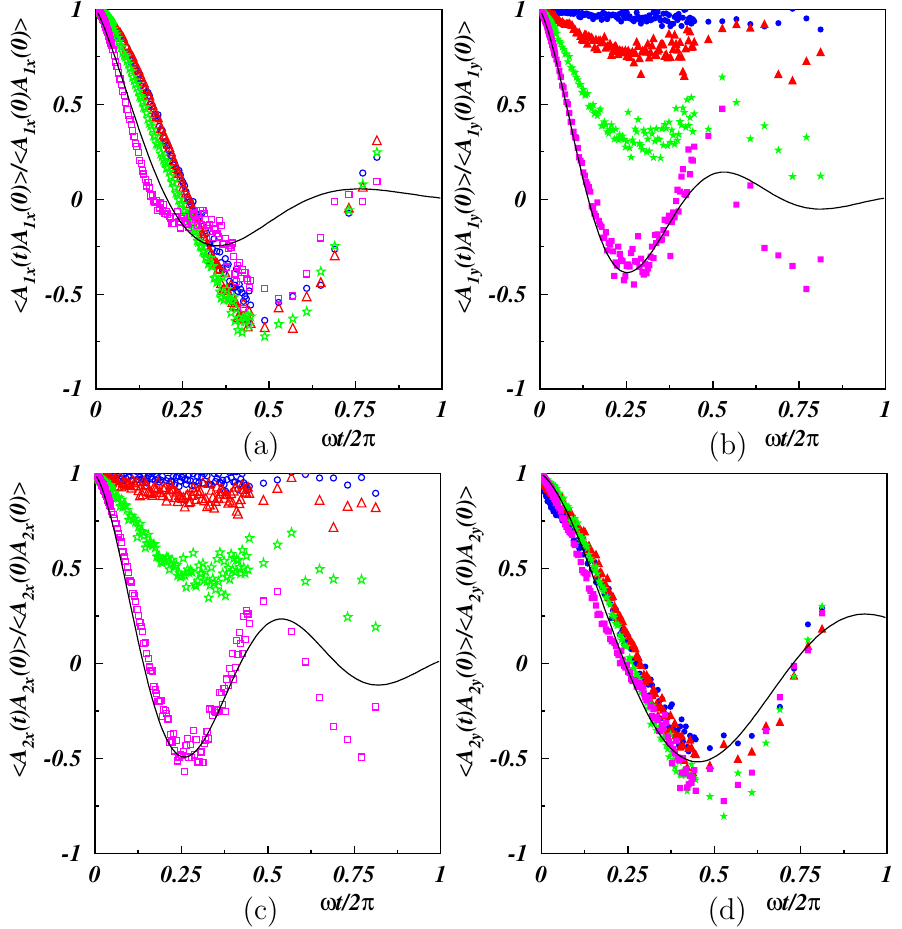
Figure 9. Autocorrelation function of the mode amplitudes for the modes n = 1 ( top ) and n = 2 ( bottom ) as a function of time along the x - ( left ) and y -direction ( right ). The polymer stiffness is L p / L = 2 and the Weissenberg numbers Wi = 10 ( ◦ ) ,25 ( (cid:52) ) ,50 ( (cid:63) ) ,100 ( fits of a damped sinusoidal